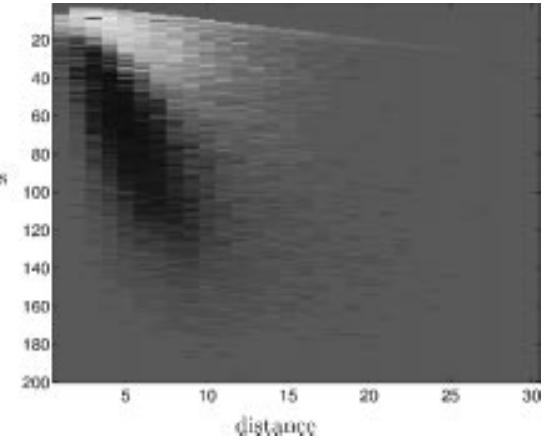
Fig. 12. 2D difference histogram of line length s versus distance in x -direction of the digital curve. This illustrates the difference be- tween the mean normalized histograms extracted from all cells in the tumour and normal classes, computed for tolerance T WD = 3 : 25. The histograms were extracted from the second 10% peripheral seg- ment of the cell nuclei. The lighter area corresponds to line segments that are more probable for the tumour class than for the normal class and the darker area corresponds to line segments that are less proba- ble for the tumour class than for the normal